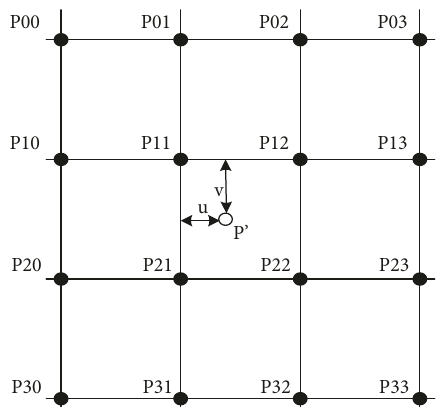
Figure 2: Bicubic interpolation